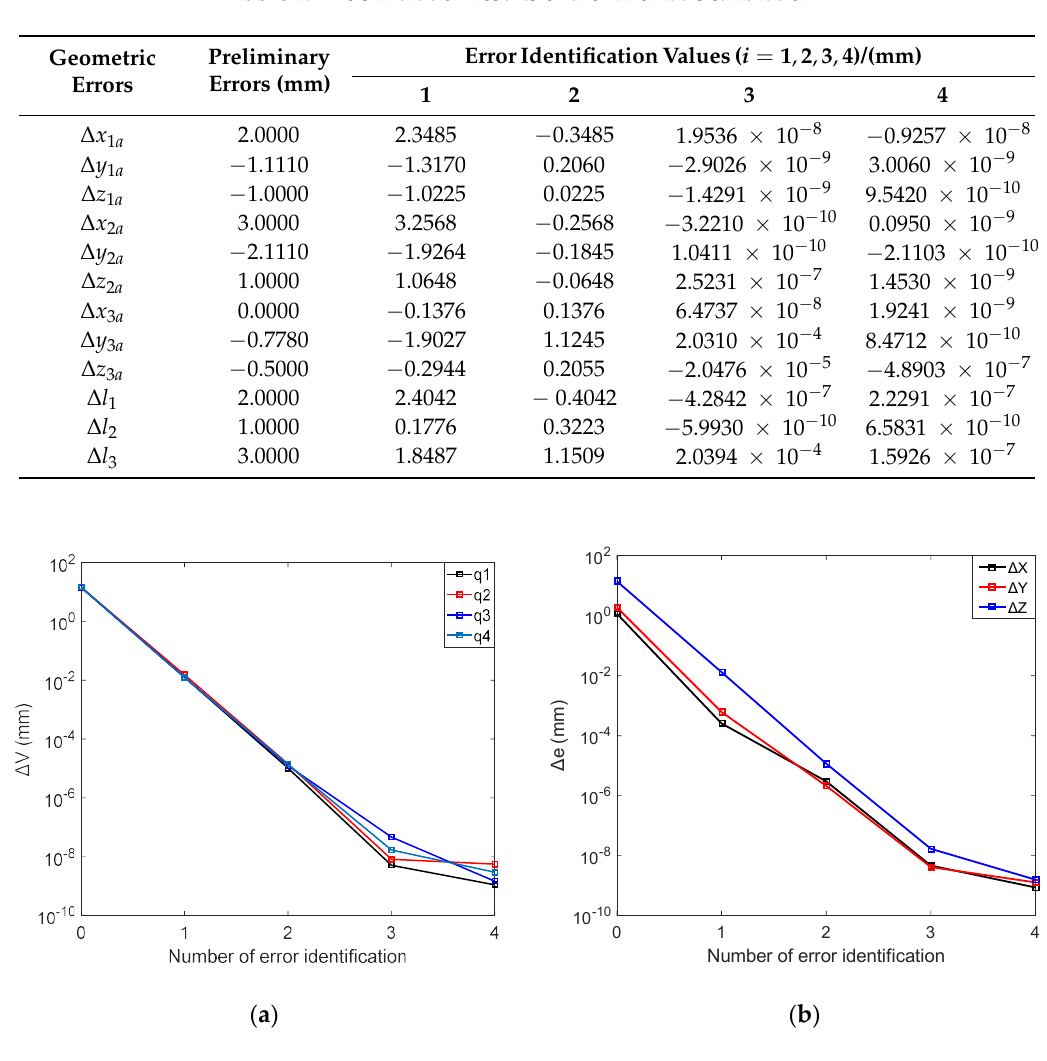
Table 2. The simulation results of the kinematic calibration.